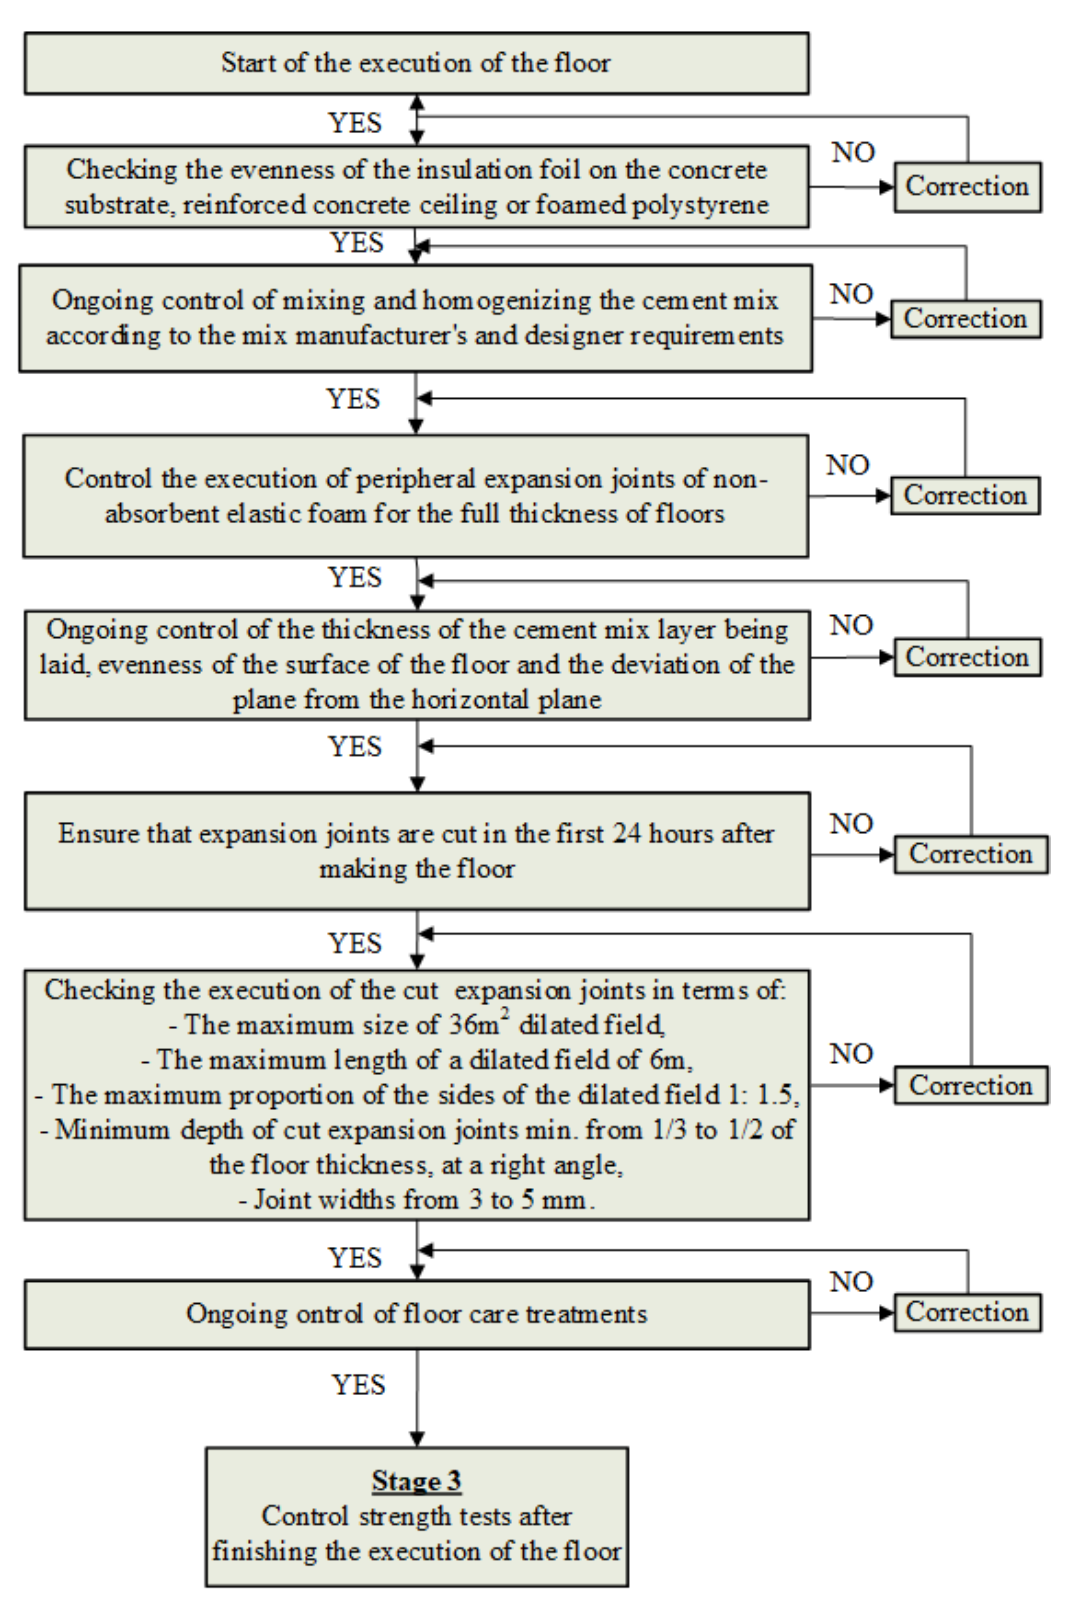
Figure4. Methodologyofcontrollingthetechnologicalprocessofexecutingfloorsmadeofcement-based Figure 4. Methodology of controlling the technological process of executing floors made of materials—Stage 2 (ongoing control during execution of the cement-based materials—Stage 2 (ongoing control during execution of the floor).